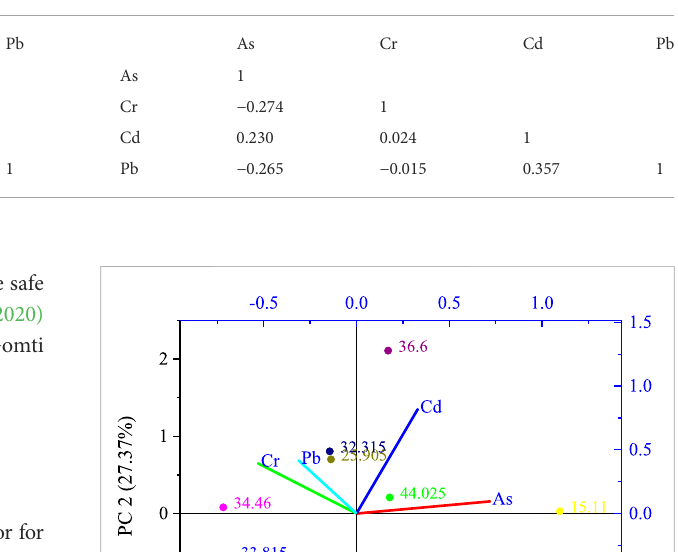
TABLE 5 Correlation matrix of heavy metals in sediment of Rupsha River, Bangladesh.